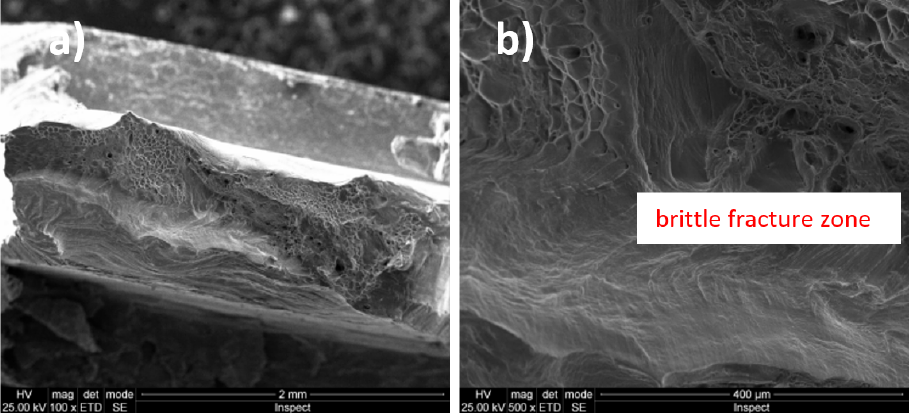
Figure 5. Fracture surfaces (fractography) images of Ti20Mo7Zr15Ta alloy: ( a ) 100×; ( b ) 500×.